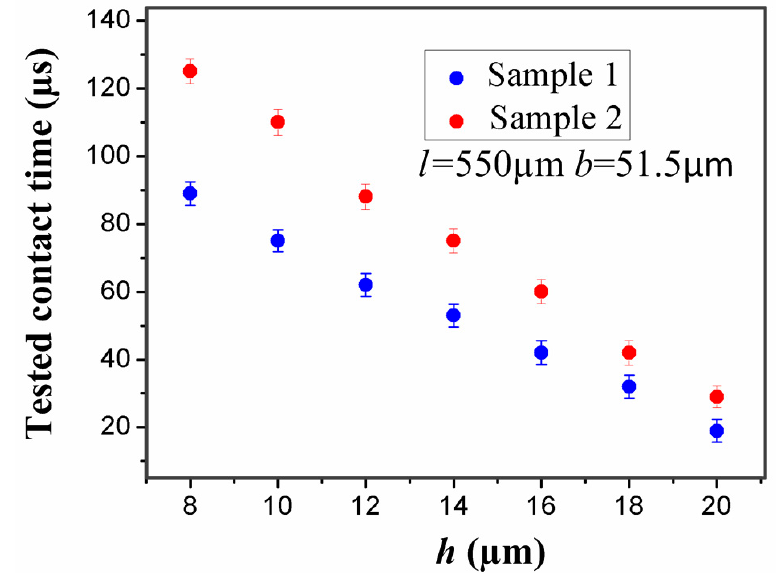
Figure 17. Dependence of the test contact time on the thickness ( h ) of the stationary electrode when the acceleration amplitude is 288 g.